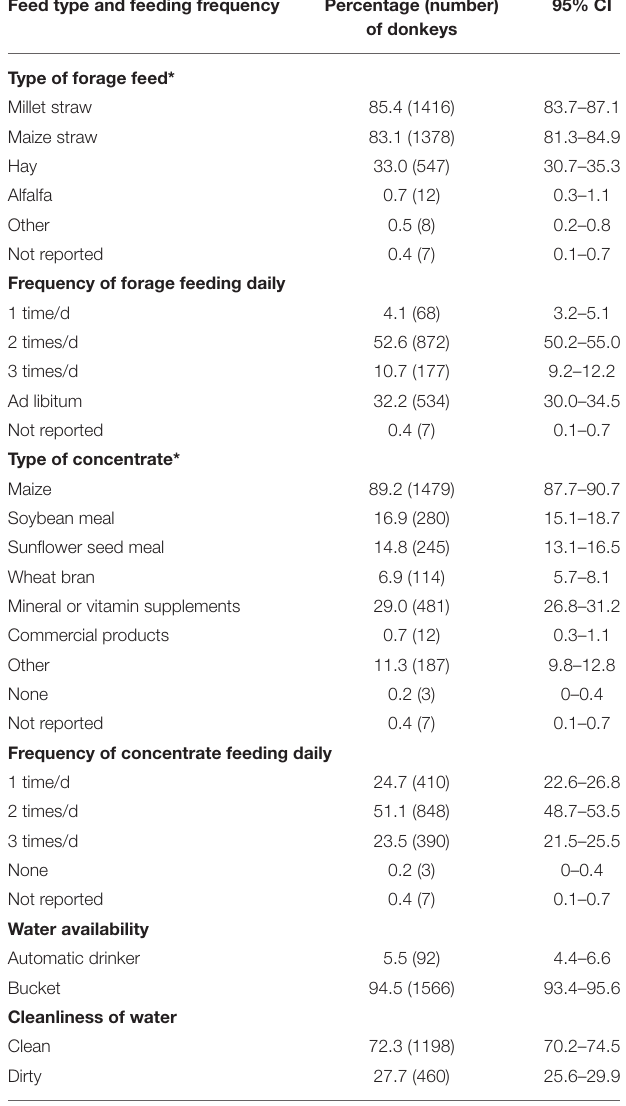
TABLE 6 | Stable and turnout management of donkeys across smallholder farms in Western Liaoning and Eastern Inner Mongolia of China throughout the year ( n = 1,585).